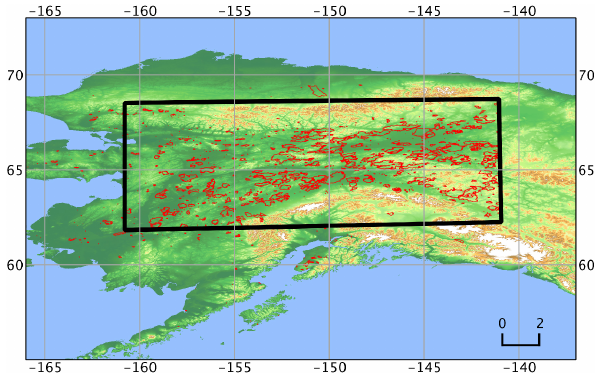
Figure 1. Location of the study area in interior Alaska (62 ◦ N– 69 ◦ N, 161 ◦ W–141 ◦ W) superimposed on an elevation map and 2002–2011 fire perimeters from the Alaska Large Fire Database